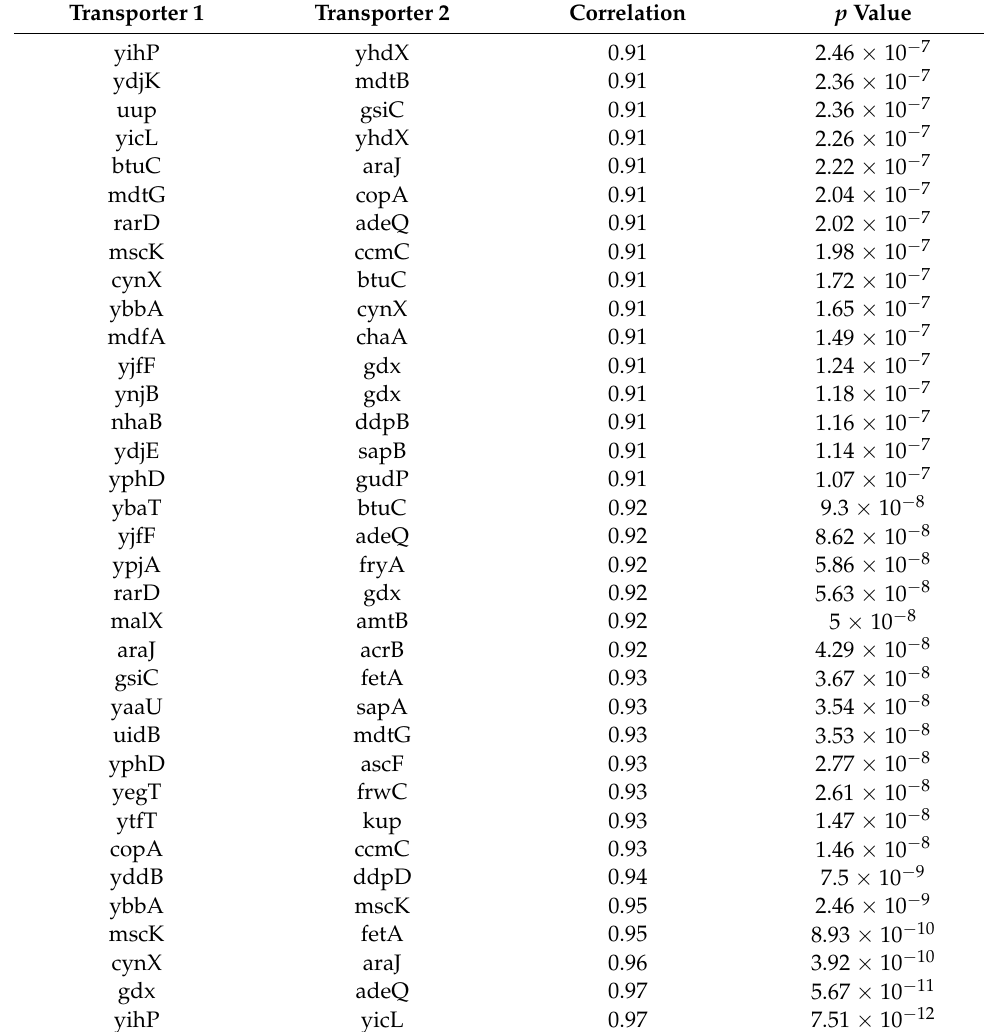
Table 5. Transporters that are highly